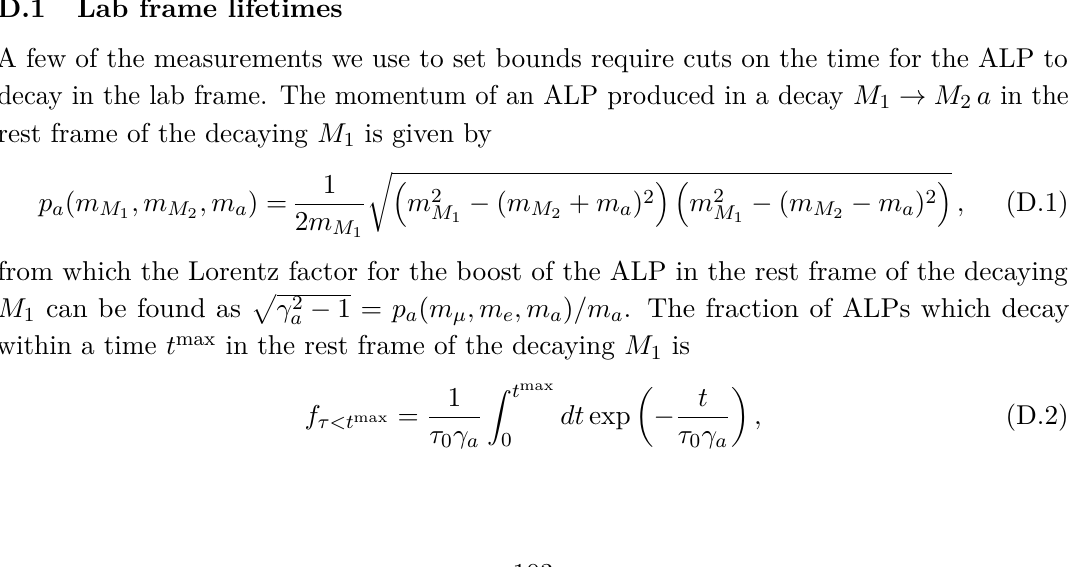
Table 8 . Observables relevant for hadronic decays of the